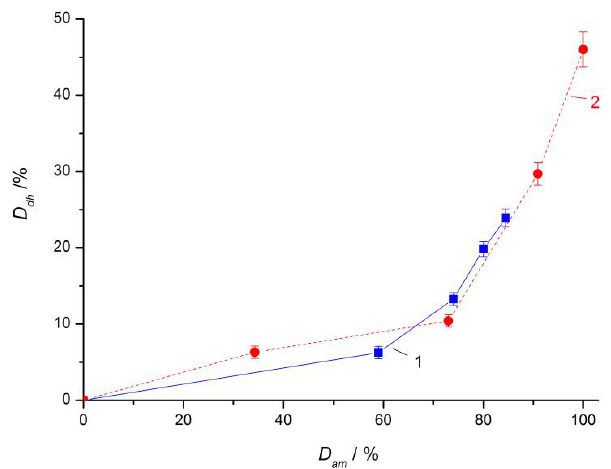
Figure 7. Degree of dehydroxylation as a function of the degree of amorphisation of antigorite from 1 : this study (mechanical activation in moderate conditions in air in the planetary mill); and 2 : vibratory milling in air [10].